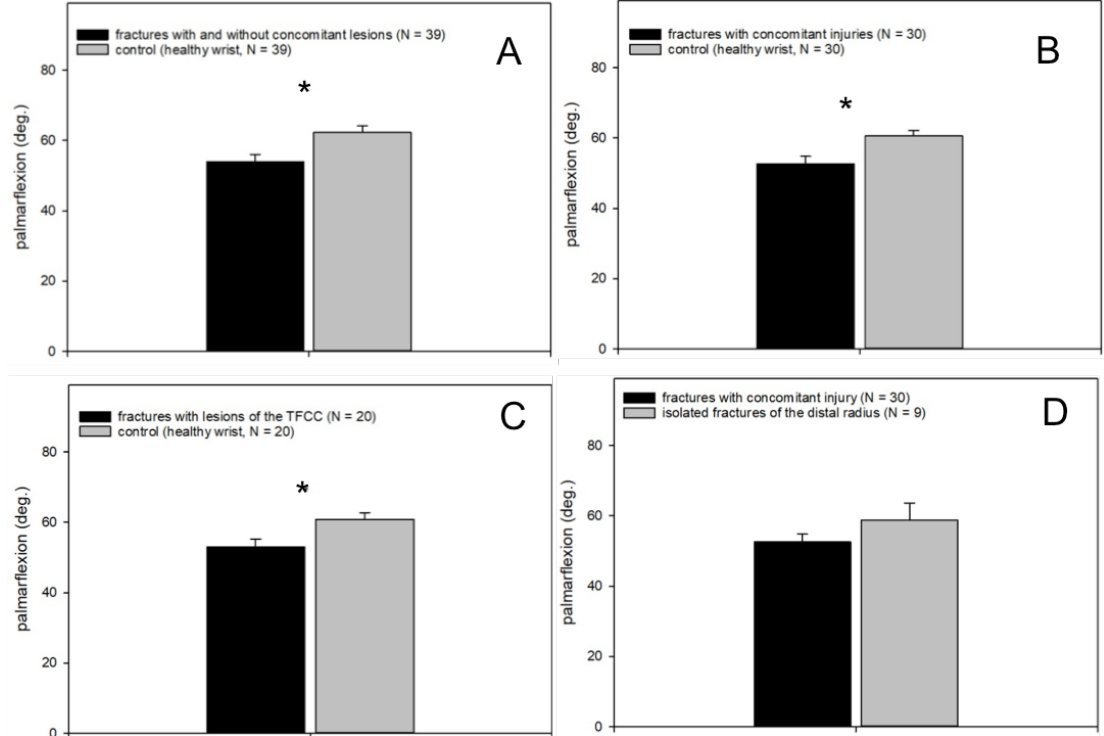
Figure 7. Palmarflexion. ( A ) Significantly reduced palmarflexion in the injured wrist (fracture of the distal radius with and without concomitant injuries) compared to the healthy wrist; ( B ) significantly reduced palmarflexion in fractures with concomitant injuries compared to the healthy wrist; ( C ) significantly reduced palmarflexion in fractures with concomitant TFCC lesions compared to the healthy wrist; ( D ) no difference between patients suffering from isolated distal radius fractures and those with distal radius fractures and arthroscopically treated concomitant lesions.